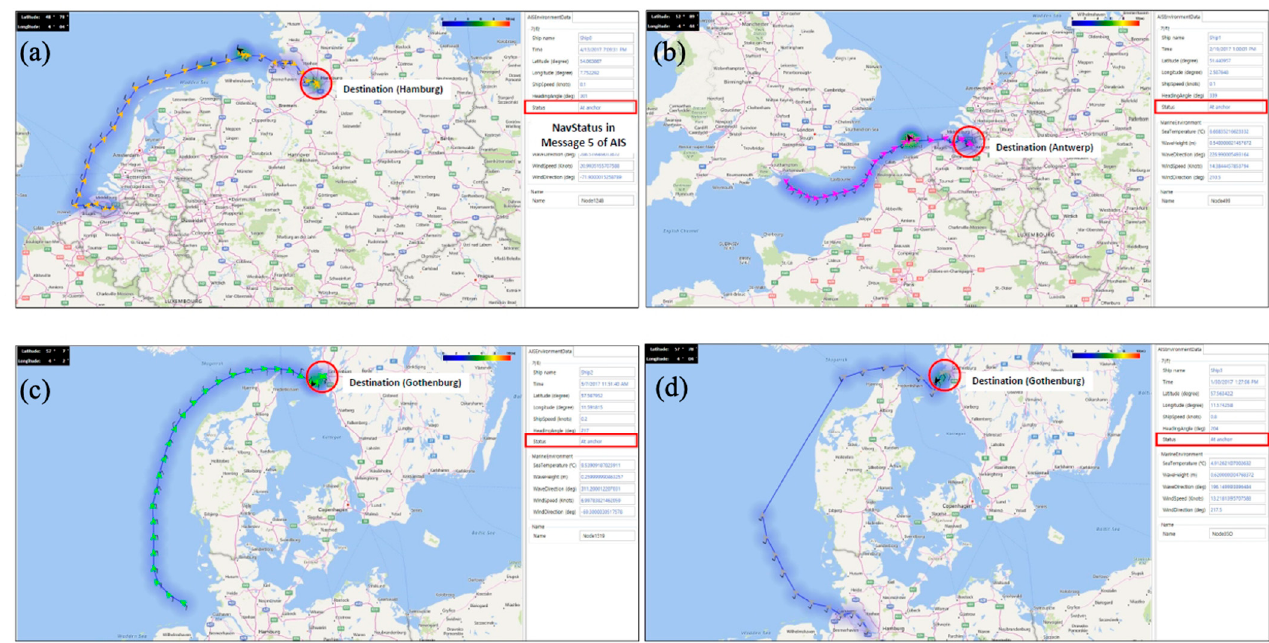
Figure 10. Mooring time analysis of 13,000 TEU container ships. ( a ) Ship 1, mooring period: 13~15 April, 2017 (46 hours), ( b ) Ship 2, mooring period: 19~21 February, 2017 (60 hours), ( c ) Ship 3, mooring period: 7~10 May, 2017 (75 hours), (d) Ship 4, mooring period: 30 January~1 February, 2017 (47 hours).